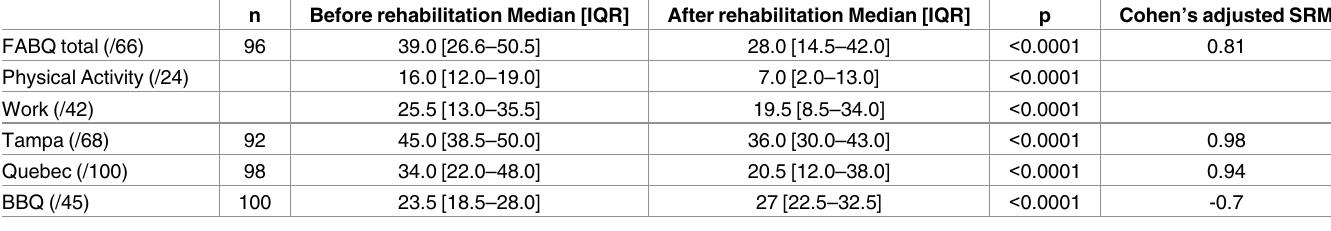
Table 2. Responsiveness of the BBQ compared to different scores before and after the rehabilitation